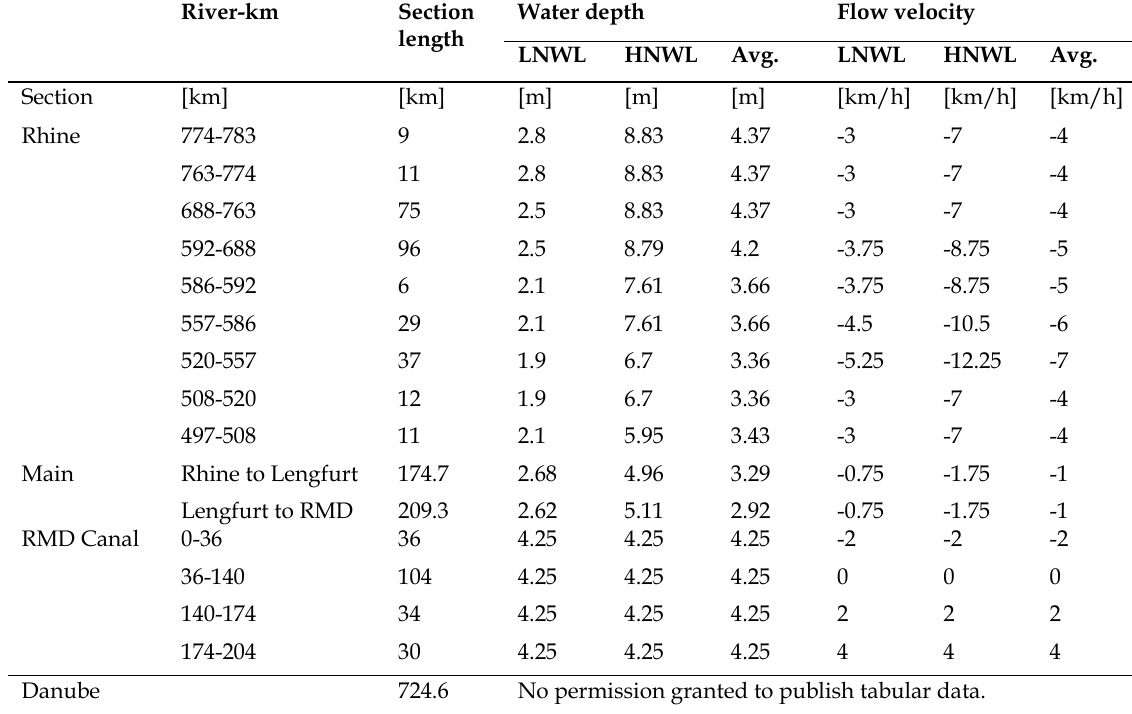
Table 1. Data of waterway sections in the case